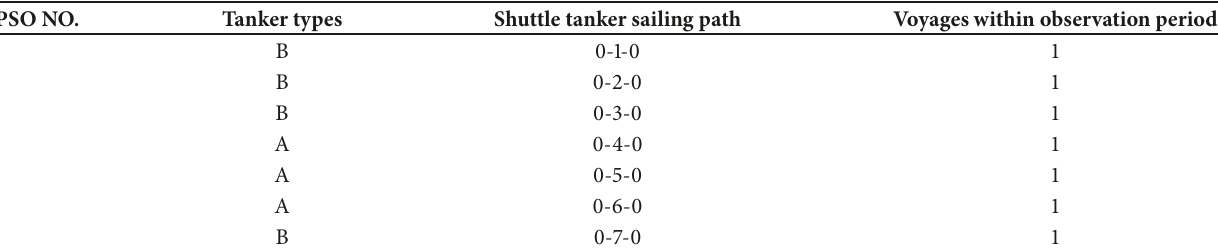
Table 4: Transportation schedule of scheme 1.